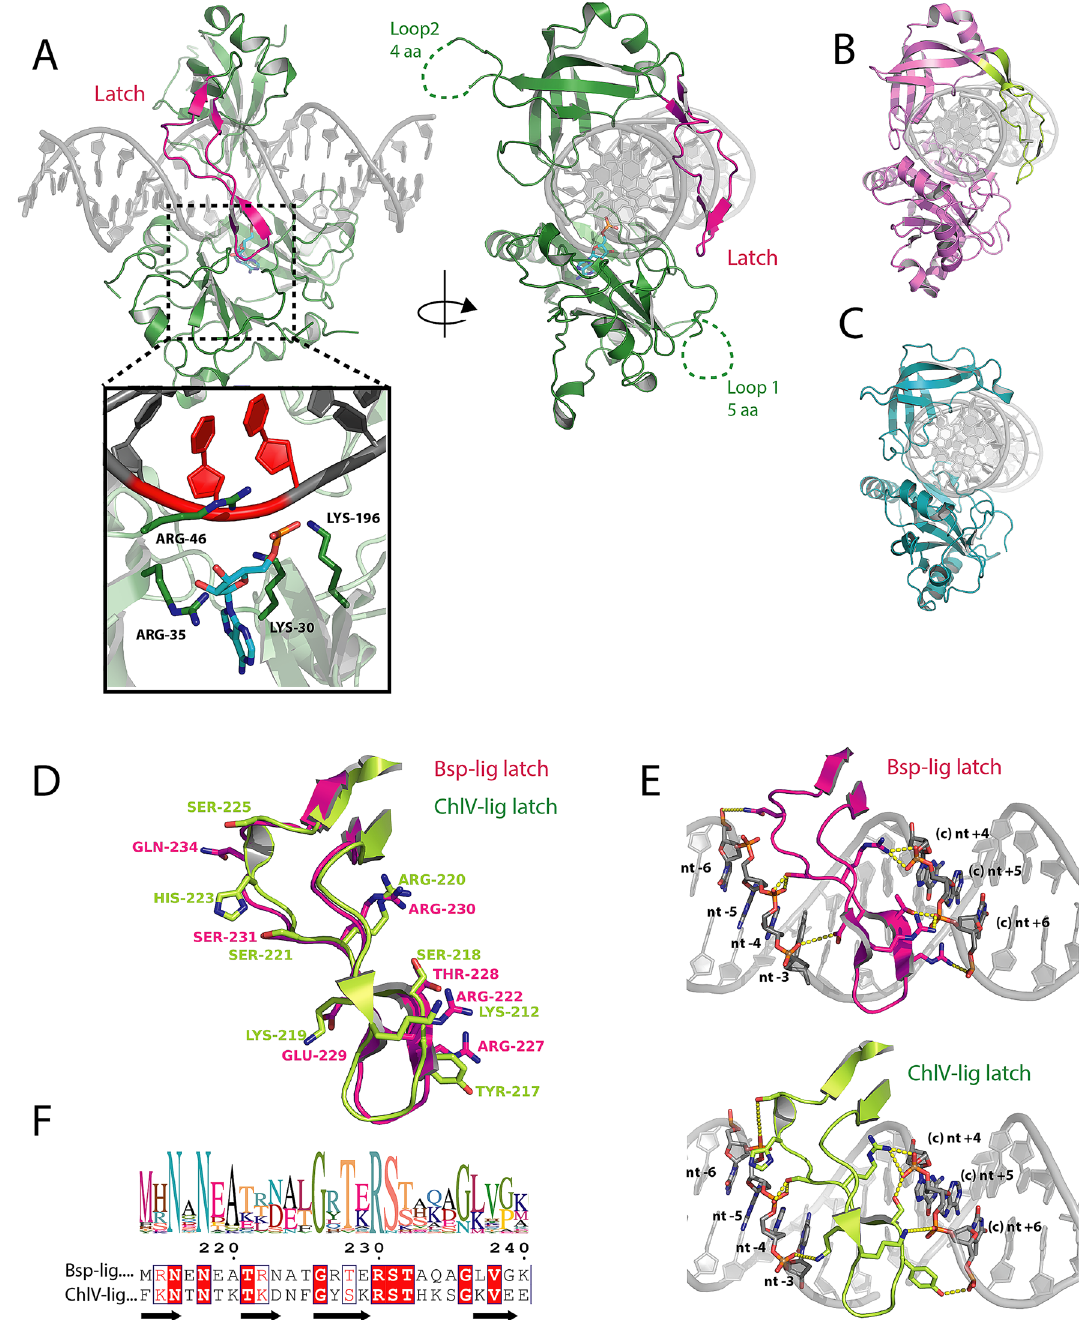
Figure 4. Structure of Bsp-lig bound to post-ligation product DNA. ( A ) Overall structure with latch region highlighted in magenta. Inset shows Bsp-lig active site with ligated nucleotides in DNA substrate indicated in red. AMP in cyan and key active site residues of Bsp-lig as green sticks. ( B ) Structure of ChlV-lig bound to DNA with latch highlighted in lime. ( C ) Structure of Ame-lig bound to DNA. ( D ) Superposition of latch regions from Bsp-lig (magenta) and ChlV-lig (lime) with key DNA-interacting residues shown as sticks. ( E ) Detailed view of interactions of Bsp-lig latch (magenta, top) and ChlV-lig latch (lime, lower) with DNA. DNA nucleotides and protein side-chains involved in interactions are shown as sticks, hydrogen bonds and salt bridges are indicated with yellow dashed lines. ( F ) Sequence logo of latch region for 28 Bsp-lig homologs (top) and alignment between latches of Bsp-lig and ChlV-lig (lower) with fully-conserved residues highlighted in red and synonymous differences indicated in red